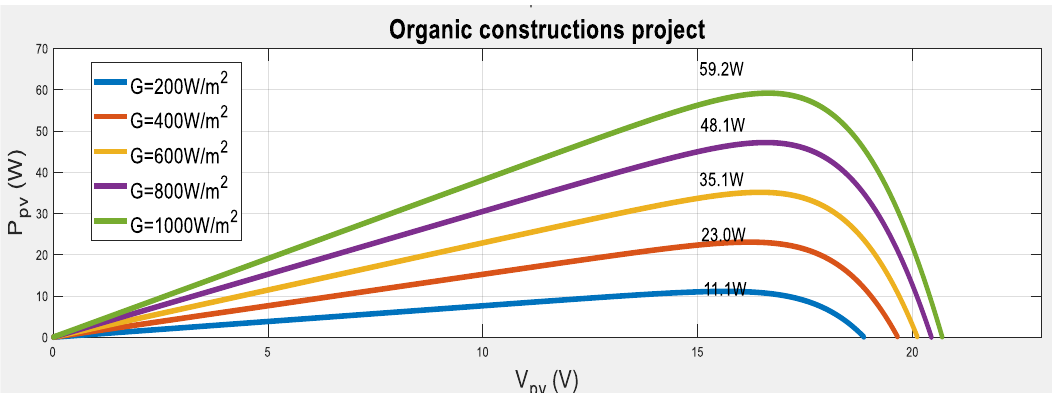
Figure 14. Voltage V pv pPower P pv curves at different values of irradiance-W/m 2 .